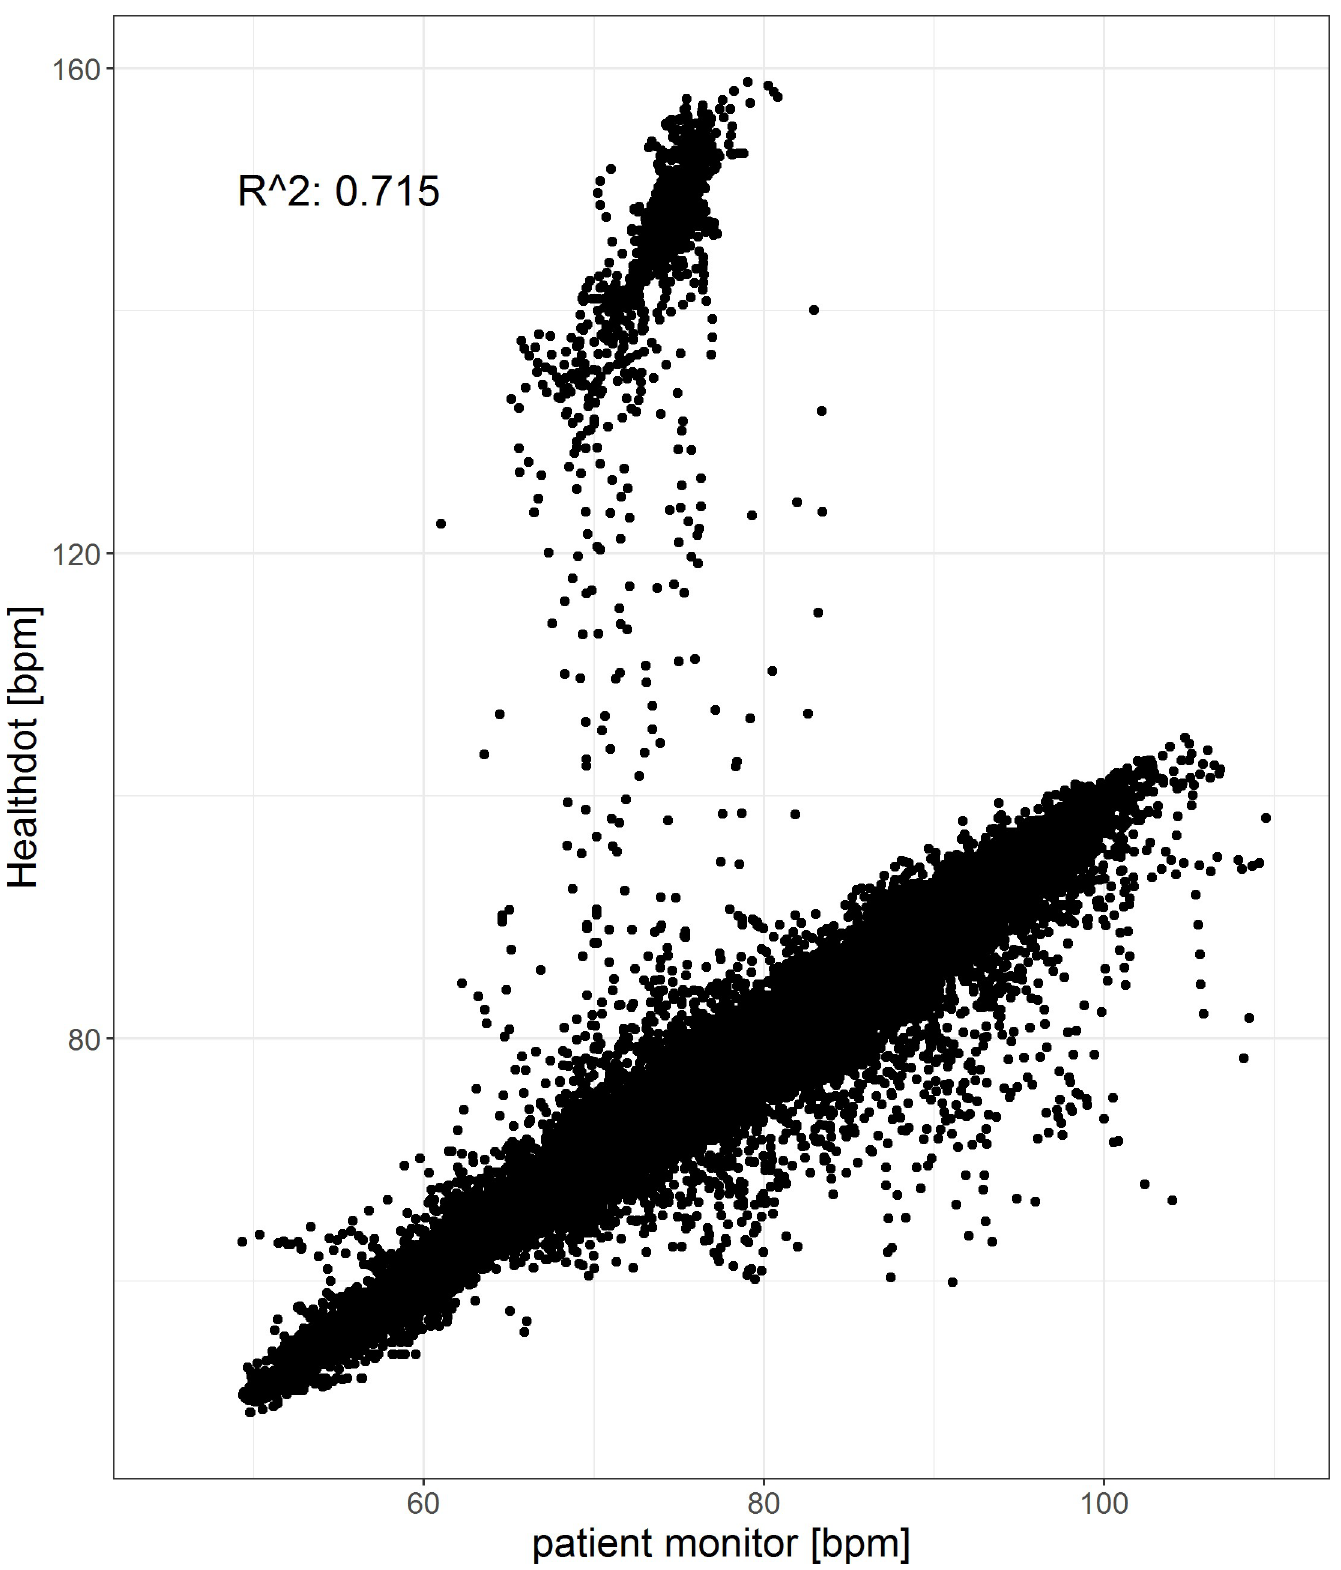
Fig 5. Correlation plot of the HeartR. The reference data (x-axis) is plotted against the Healthdot data (y-axis). The corresponding Pearson correlation coefficient is 0.72 (CI: [0.71:0.72], p < 0.001).